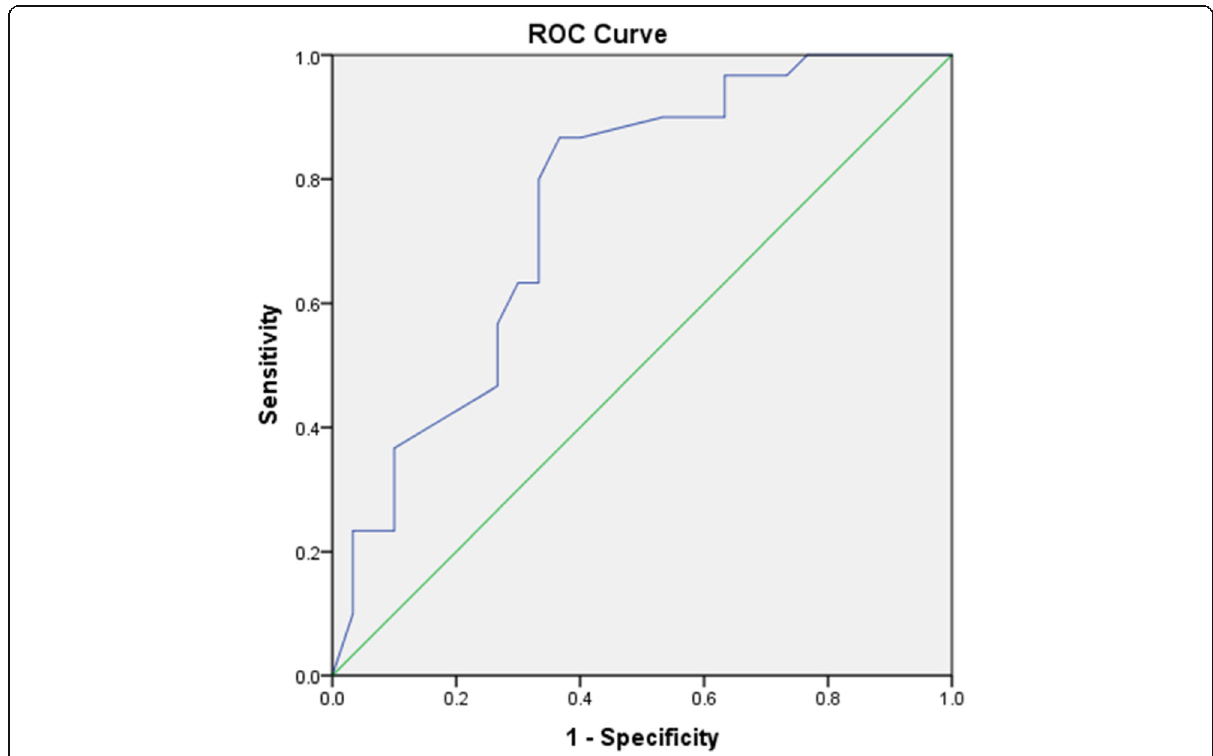
Fig. 1 ROC curve analysis to assess the sensitivity and specificity of BDNF in predicting MS disease activity